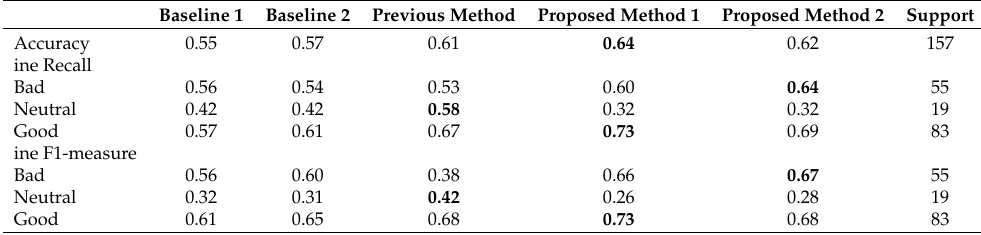
Table 9. Estimation accuracy of five methods for